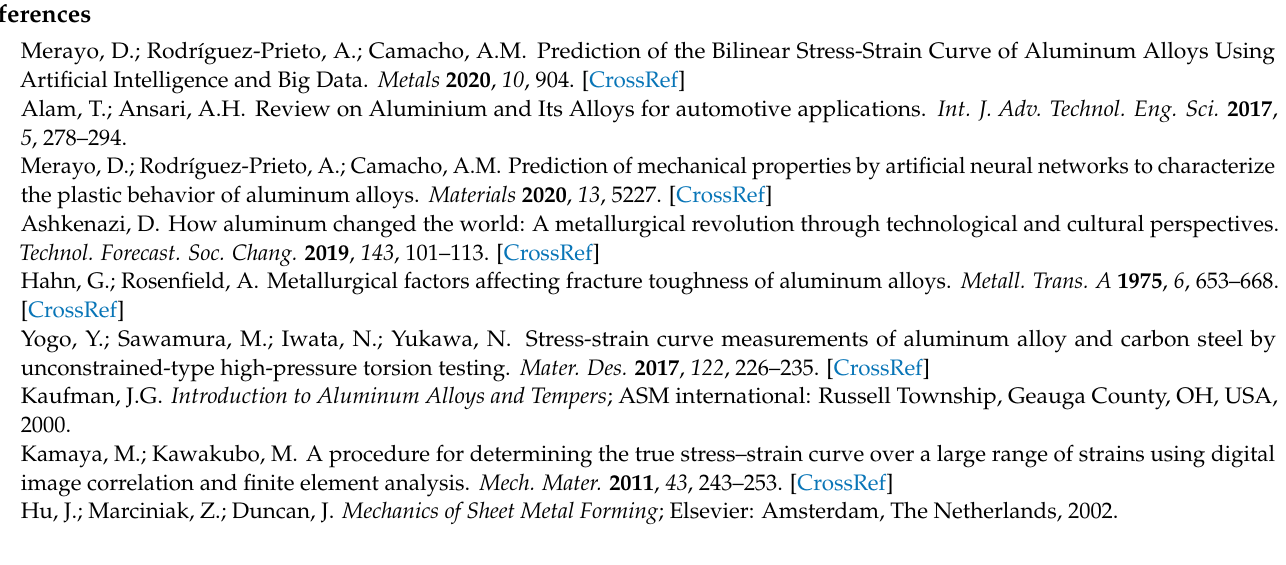
Nodes in the First Hidden Layer